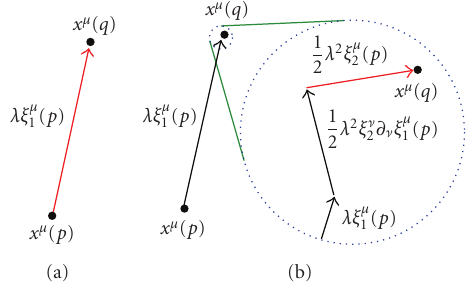
Figure 1: (a) The second term λξ 1 ( p ) in (4) is the vector which points from the point x μ ( p ) to the point x μ ( q ) in the sense of the first-order correction. (b) If we look at the neighborhood of the point x μ ( q ) in detail, the vector λξ 1 ( p ) may fail to point to x μ ( q ) in the sense of the second order. Therefore, it is necessary to add the second-order correction (1 / 2) λ 2 ( ξ μ 2 + ξ ν 1 ( p ) ∂ ν ξ μ 1 ( p